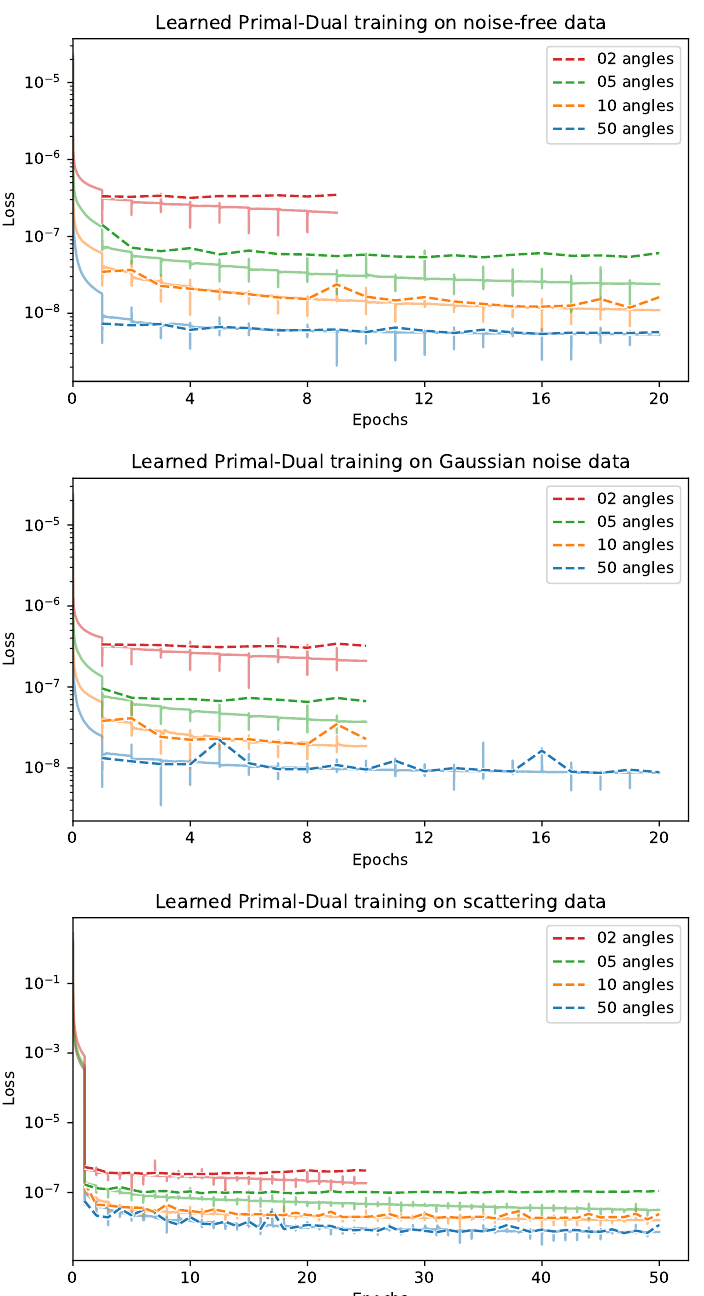
Figure A10. Training curves of Learned Primal-Dual on the Apple CT dataset. Dashed lines: average validation loss computed after every full training epoch; solid lines: running average of training loss since start of epoch. Duration of 20 epochs on full dataset: ≈ 10–17 days, varying with the number of